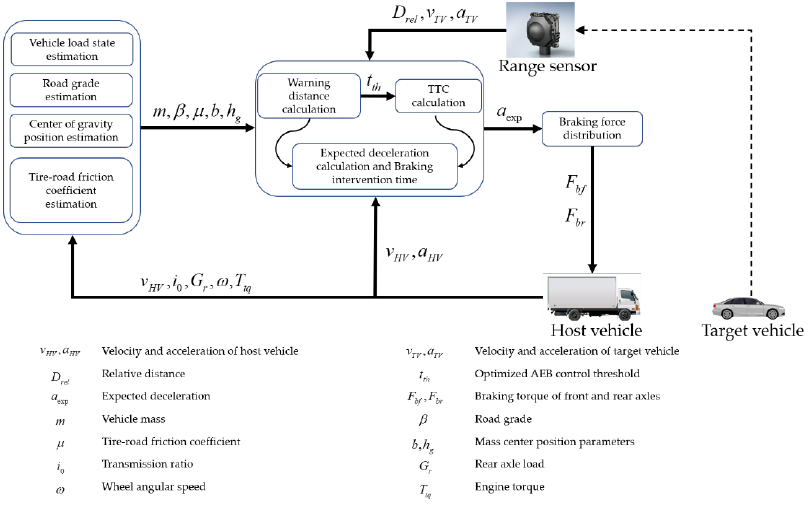
Figure 1. Control framework of the AEBS.